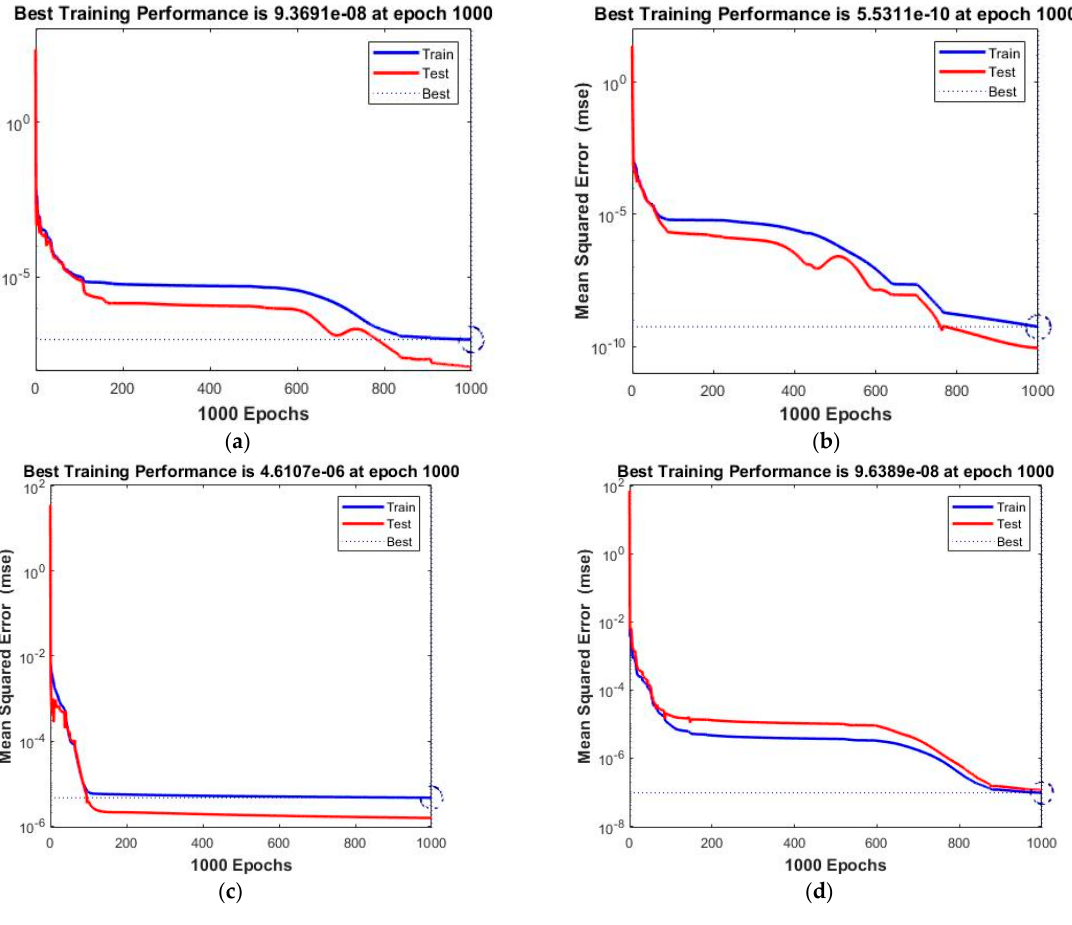
Figure 10. Performance analysis of train, validation, test, and best by BRM ‐ NNs for all four cases of the Dahl ‐ based hysteresis model. ( a ) BRM ‐ NNs Case 1. ( b ) BRM ‐ NNs Case 2. ( c ) BRM ‐ NNs Case 3. ( d ) BRM ‐ NNs Case 4.